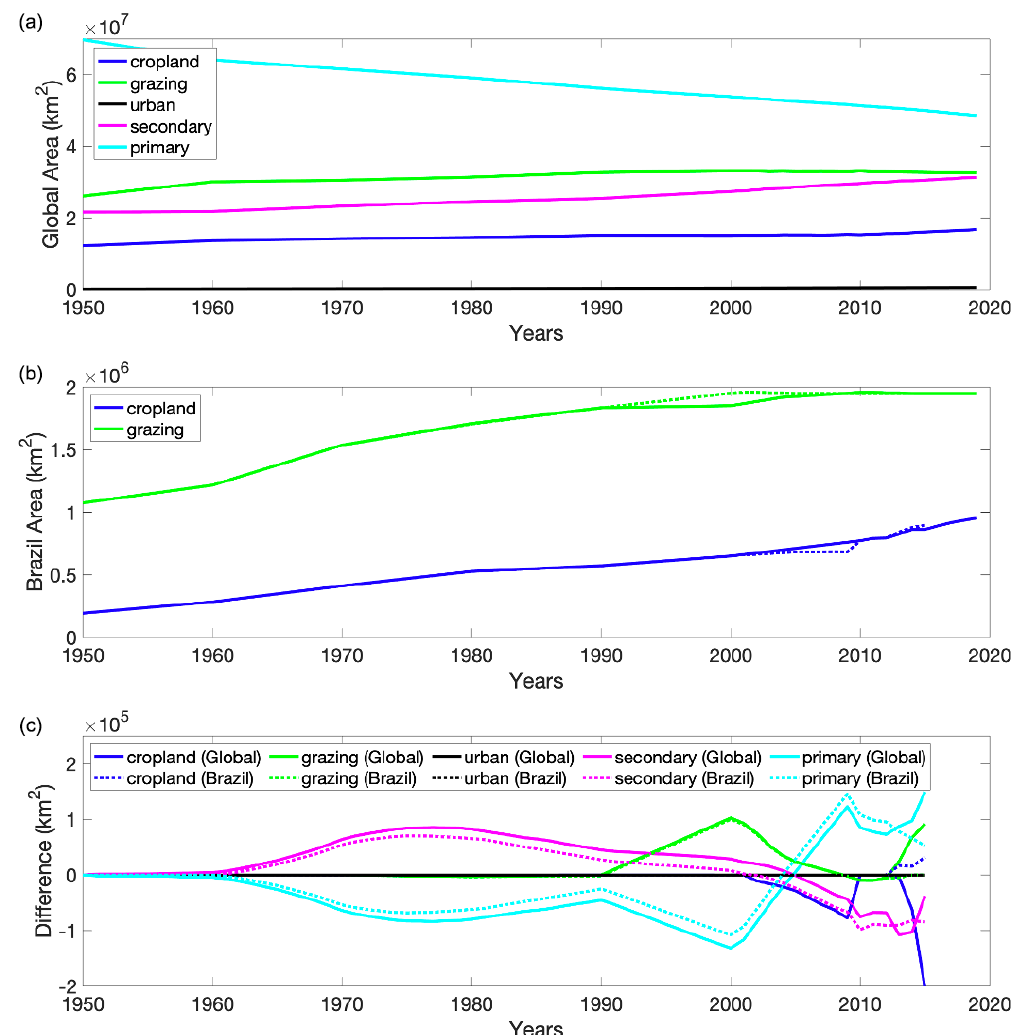
Figure 2. (a) Global area of key land-use states in LUH2-GCB2019. (b) Area of cropland and grazing land in Brazil in both LUH2-GCB2019 (solid line) and LUH2 v2h (dashed line). (c) Differences between global areas (solid lines) and Brazilian areas (dashed lines) of key land-use states (LUH2 v2h –